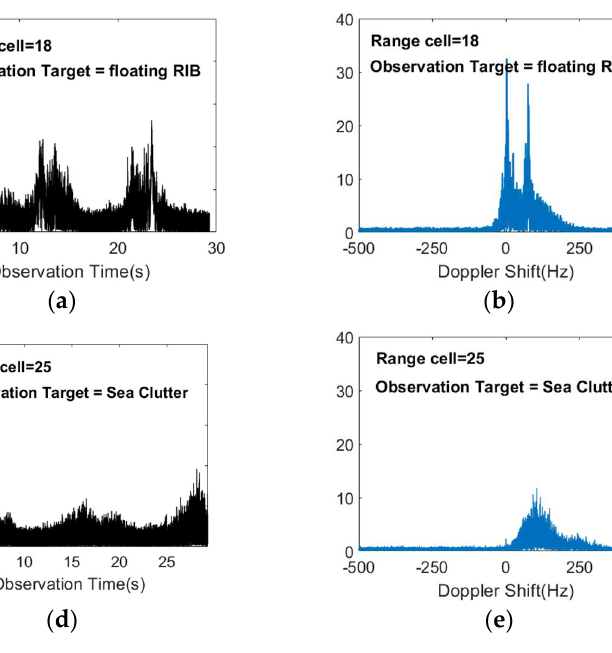
Figure 2. The multimodal data of radar echo signals in the target cells and the sea clutter cells. The radar observation target is a floating RIB and the radar echo signal sequence is the 18th and 25th range cells of the data #CSIR_03. ( a ) Amplitude sequence of the target cell; ( b ) Doppler amplitude spectrum of the target cell; ( c ) Time‒Doppler spectrum image of the target cell; ( d ) Amplitude sequence of the sea clutter cell; ( e ) Doppler amplitude spectrum of the sea clutter cell; ( f ) Time‒Doppler spectrum image of the sea clutter cell.